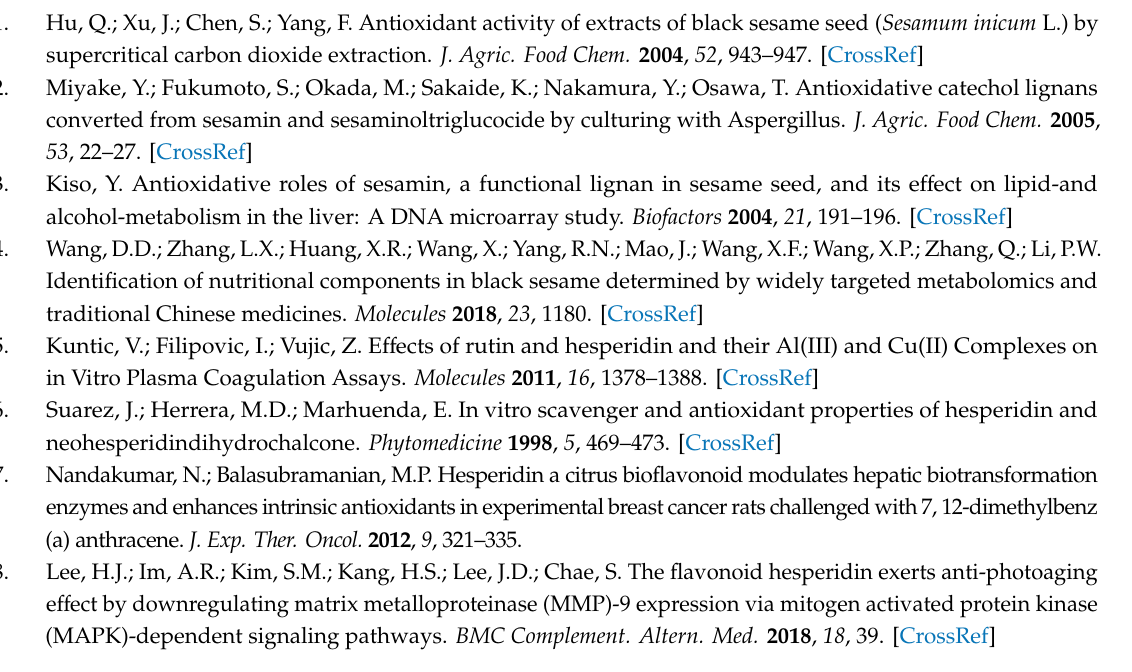
S1: Results of preliminary screening on six general parameters, Figure S2: LC-MS / MS chromatograms obtained for the standard solution of 10 targets, Figure S3: Box plot of differential compounds, Table S1: Factors and coded value of Plackett-Burman design, Table S2: Design matrix and results of Plackett-Burman test, Table S3: Factors and coded value of Box-Behnken design, Table S4: Design matrix and results of Box-Behnken test, Table S5: Analysis results of Plackett-Burman design, Table S6: Analysis results of Box-Behnken